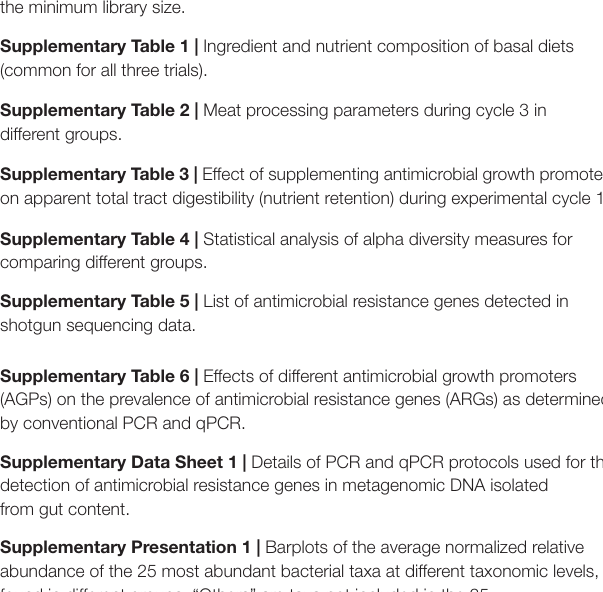
the minimum library size. Supplementary Table 1 | Ingredient and nutrient composition of basal diets (common for all three trials). Supplementary Table 2 | Meat processing parameters during cycle 3 in different groups.